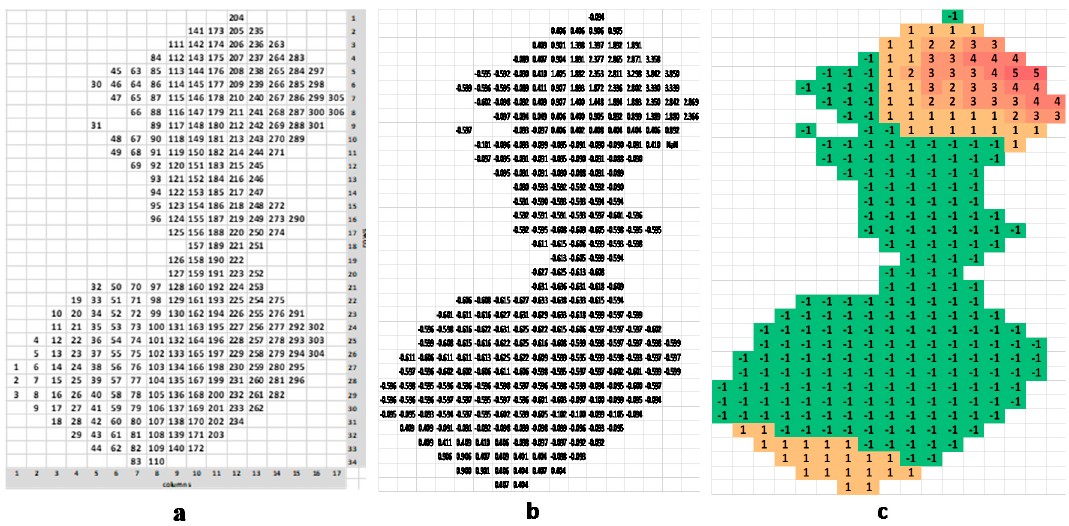
Figure 9. ( a ) Landfill pixels numbered from 1–306; ( b ) normalized data of observation 15 April 2011; ( c ) equivalent HI. (Blank squares = NaN values (nonblank)).